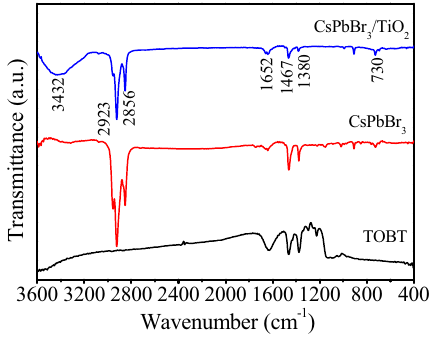
nanocrystals and CsPbBr 3